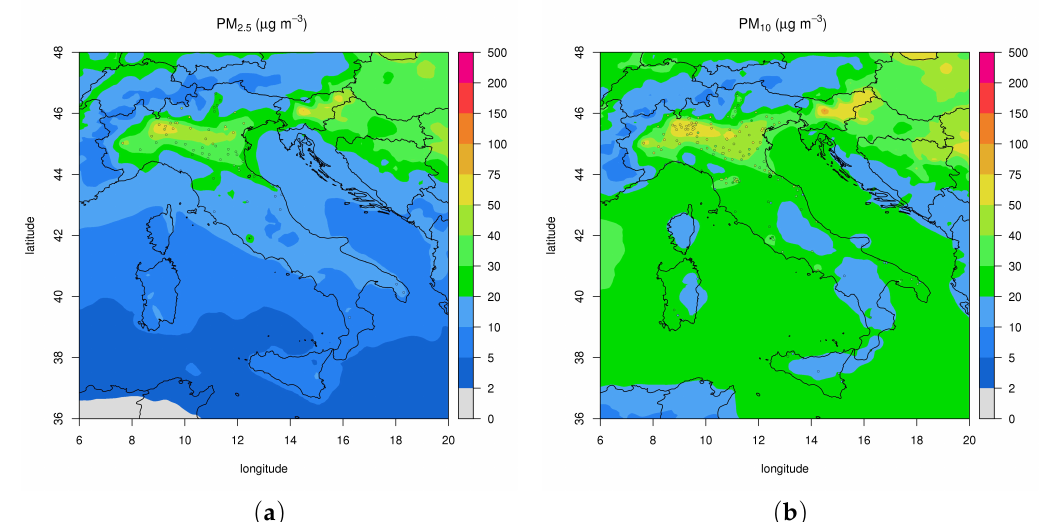
Figure 13. Seasonal average of model (maps) and measurements (filled circles) of PM 2.5 ( a ) and PM 10 ( b ) concentration ( µ g m − 3 ) for DJF season.